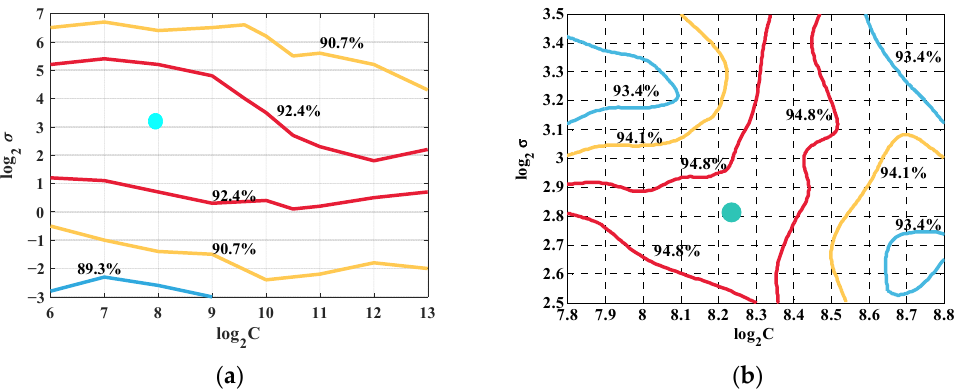
Figure 9. Parametric optimization of contour map by quadratic grid search method: ( a ) parameter selection for initial grid partitioning and ( b ) parameter selection of secondary meshing.